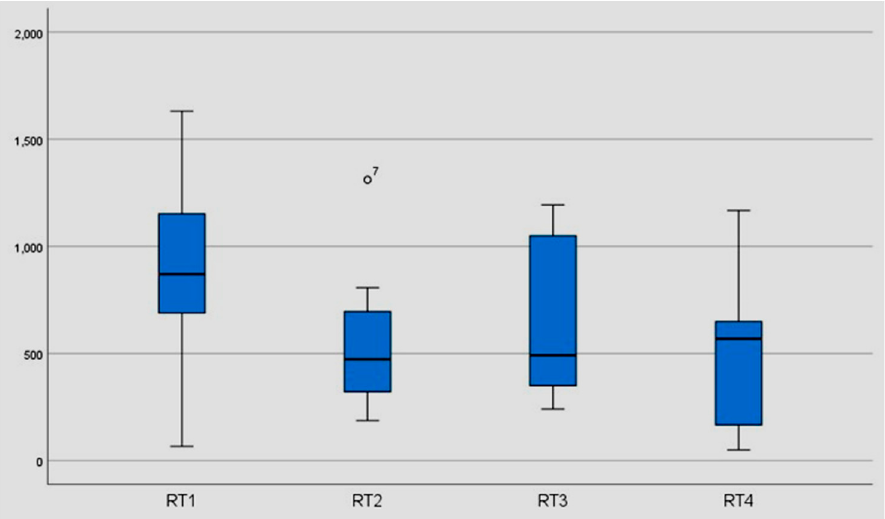
Figure 8. Reaction time of the individual threshold stereo acuities for the static stereo test. The results of the total group before training (RT1), after three weeks of training/ n = 1536 trials (RT2), after six weeks of training/ n = 3072 trials (RT3), and after six months without training (RT4). For better illustration, presented without the results of participant number six. ⭕ , 7: Participant number seven represents a “mild outlier” in the box plot diagram.